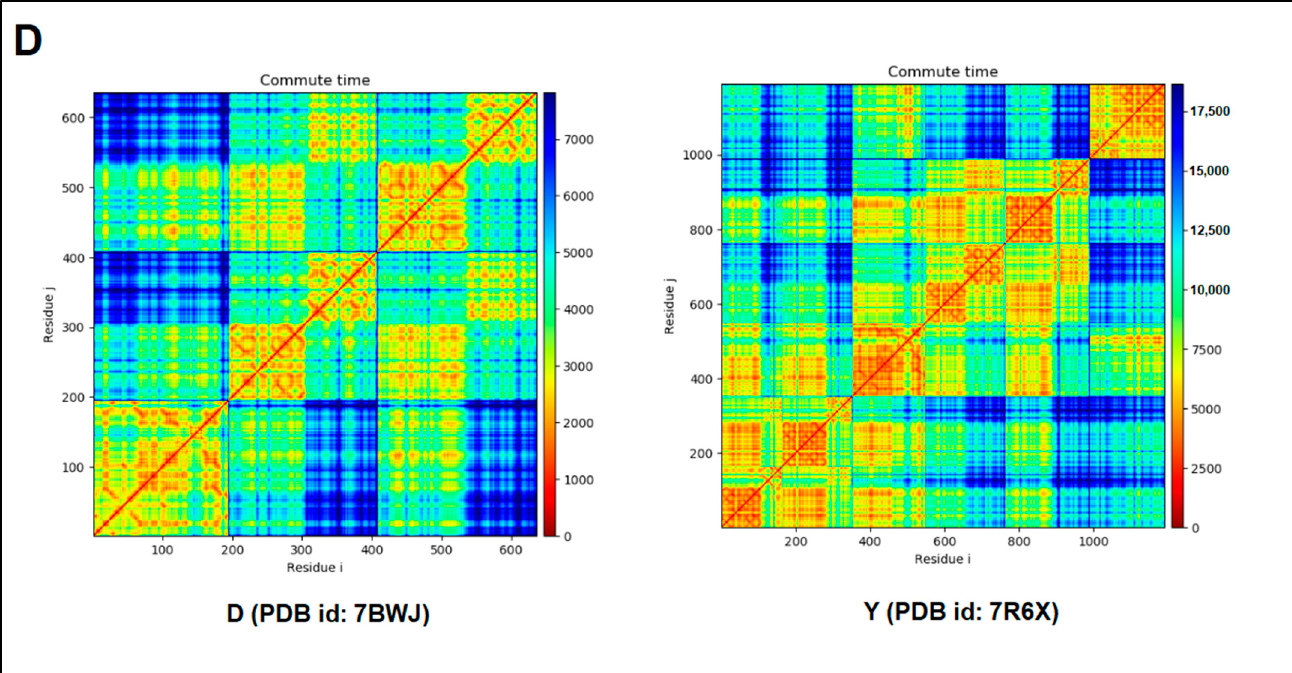
Figure 9. The schematic representation for developing a 2D map for the signaling rate, signaling receiving time, and signaling communication time from protein residues of SARS-CoV-2 proteins and non-SARS-CoV-2 proteins. ( A ) The schematic representation to develop a 2D map of the signaling rate, signaling receiving time, and signaling communication time from protein residues of SARS-CoV-2 proteins and non-SARS-CoV-2 proteins. ( B ) The 2D map of the signaling rate, signaling receiving time, and signaling communication time from protein residues of 3D structures of proteins which are used to develop the word “SARS-CoV-2”. ( C ) The 2D map of the signaling rate, signaling receiving time, and signaling communication time from protein residues of 3D structures of proteins which are used to develop the word “COVID-19”. ( D ) The 2D map of the signaling rate, signaling receiving time, and signaling communication time from protein residues of 3D structures of two SARS-CoV-2 protein alphabets with antibodies/immunological or vaccine-associated roles used in this study. The comprehensive analysis tried to capture the functionality of residue.